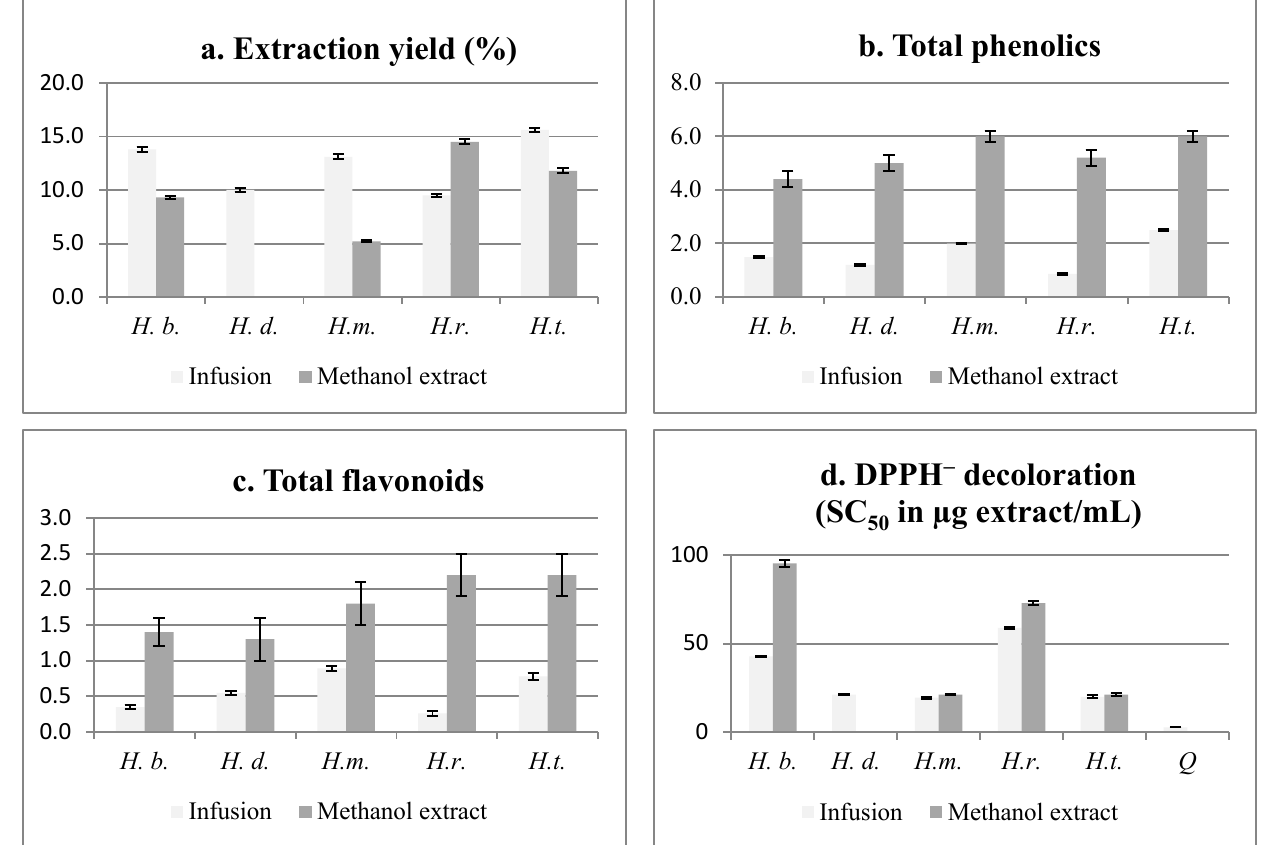
Figure 2. Comparison of the infusion and methanol extract from the aerial parts of “baylahuen” ( Haplopappus spp.) in the following parameters: ( a ) percent w / w extraction yield; ( b ) total phenolics (TP); ( c ) total flavonoids (TF); and ( d ) scavenging of the free radical, DPPH